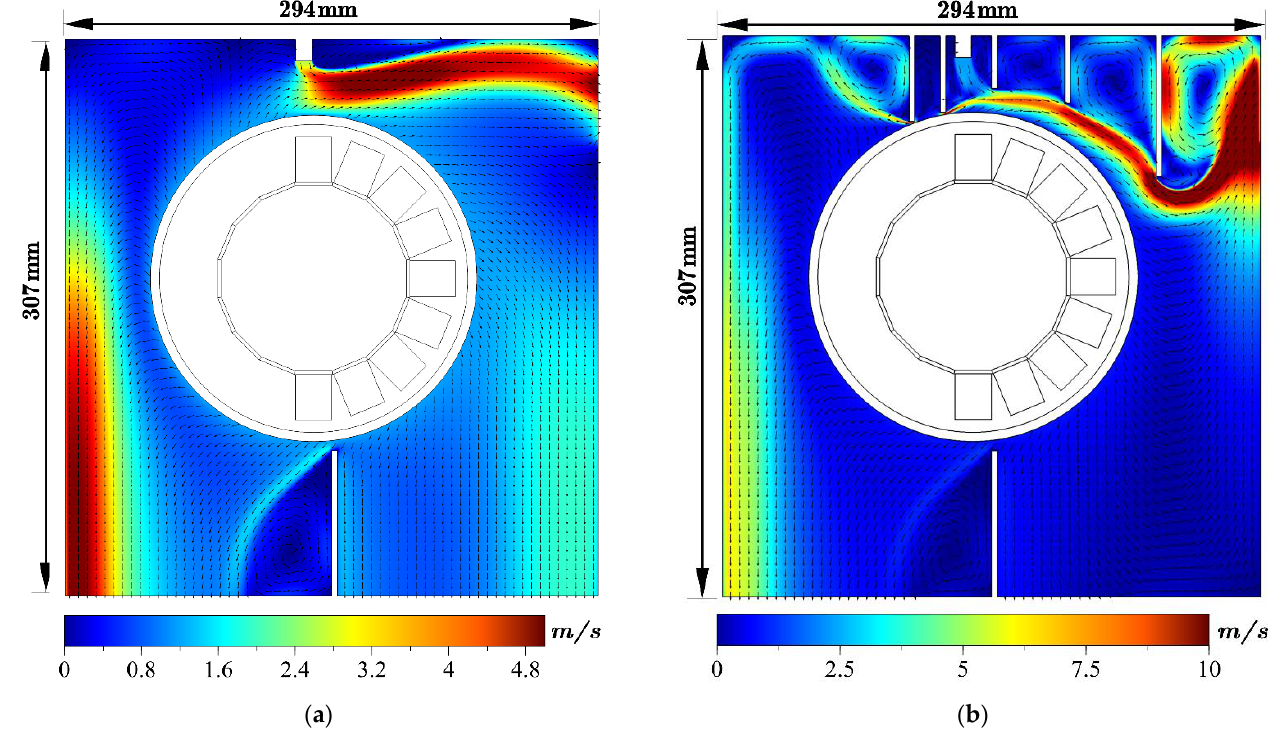
Figure 3. Airflow velocity field distribution of the original ( a ) and improved ( b ) pneumatic drum magnetic separator.